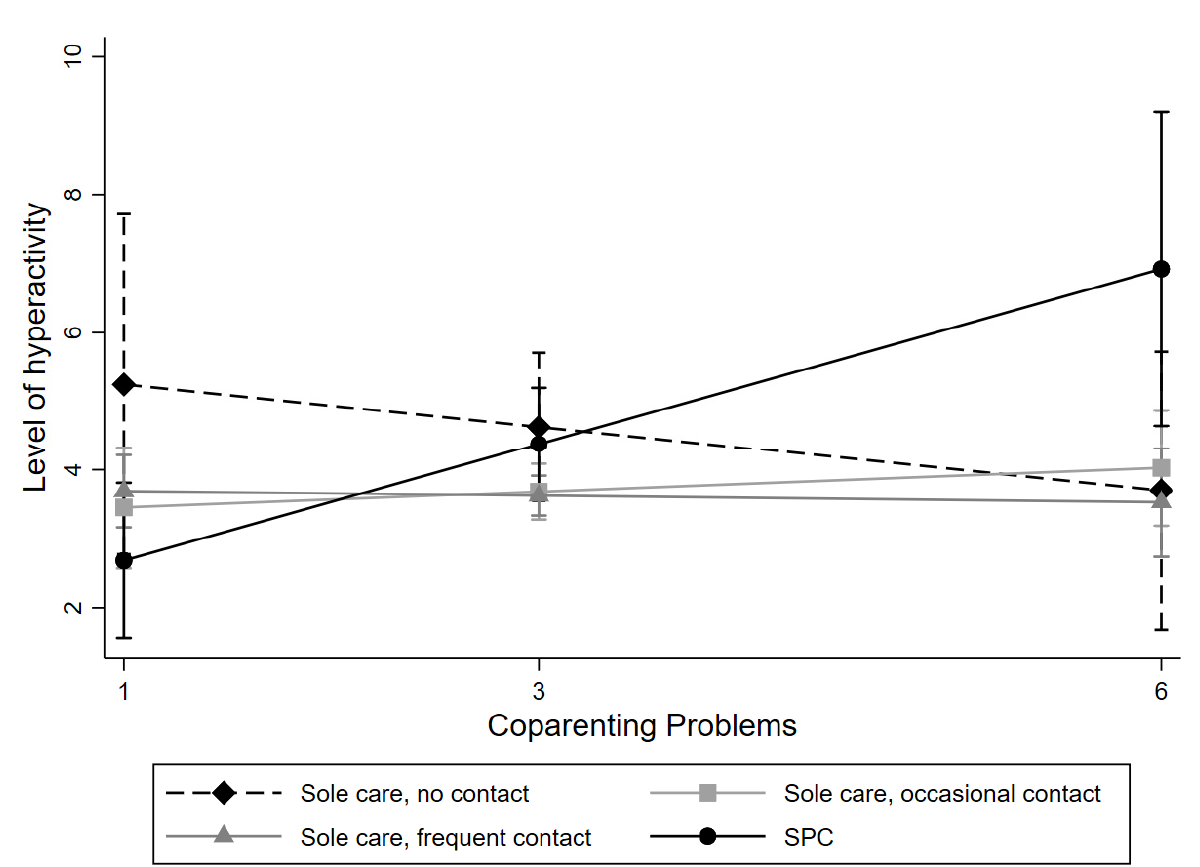
Figure 3. Significant interaction effect between post-separation physical custody arrangement and coparenting problems for the SDQ subdimension hyperactivity.